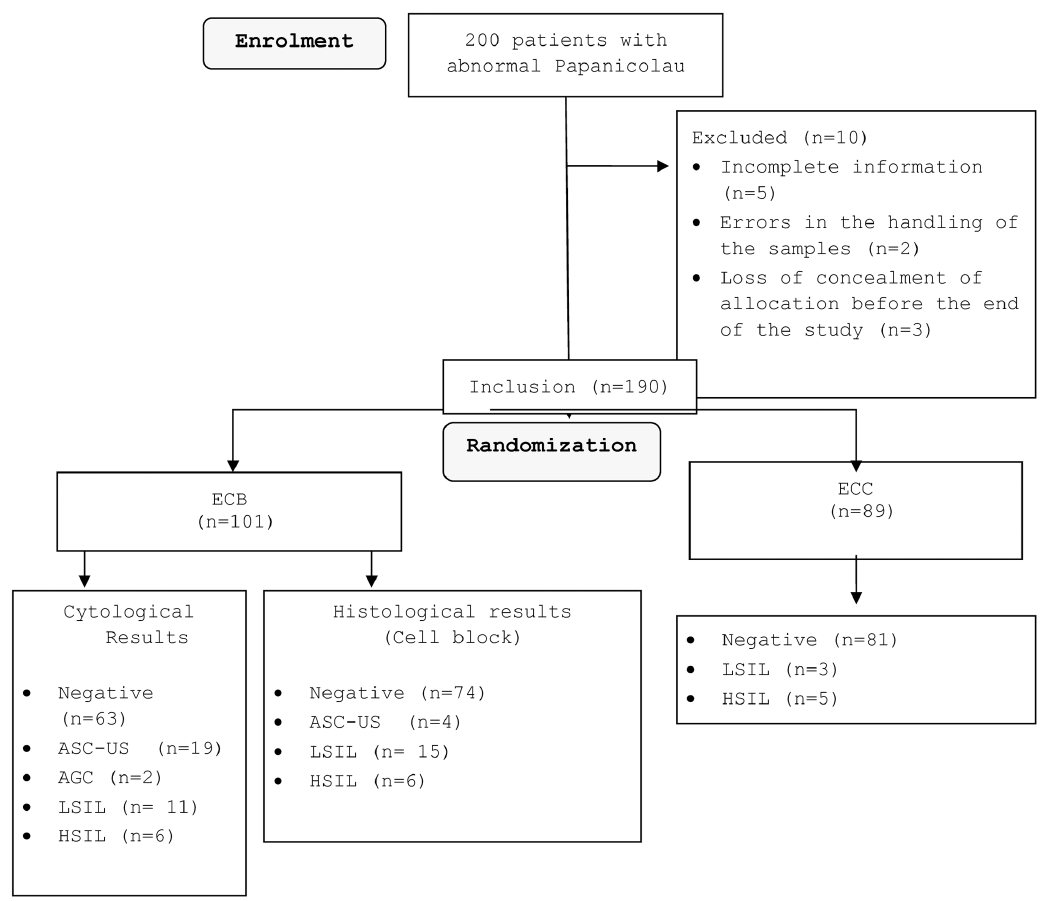
Fig 1. Flowchart of study participants. ECB: endocervical brushing, ECC: endocervical curette.